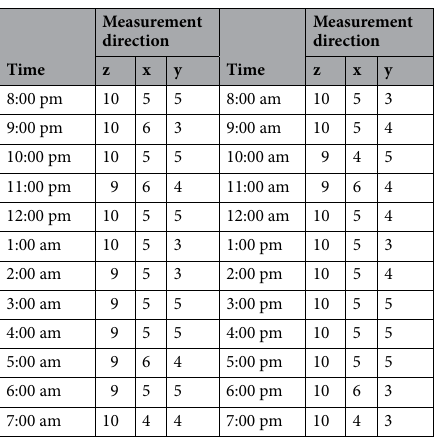
Table 4. Critical frequency of the significant separation point between the signals